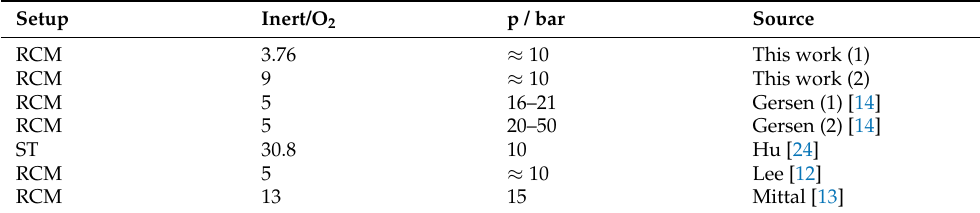
Table 4. Overview of IDT as shown in Figure 2 for pure H 2 and stoichiometric conditions.